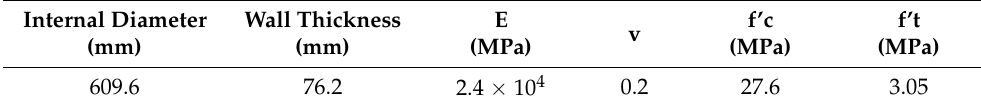
Table 2. Dimensions and material properties of the concrete pipe.